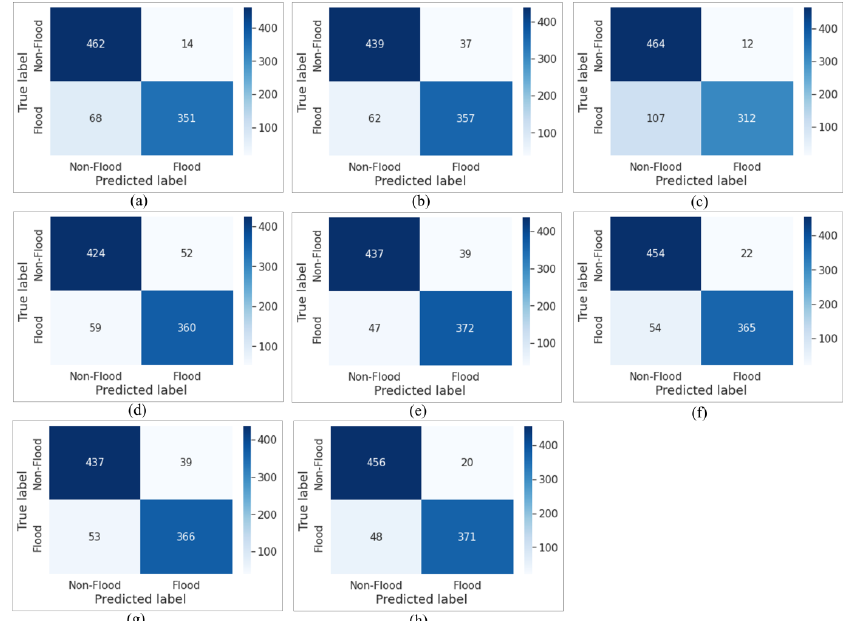
Figure 12. Comparing the confusion matrices of different SFM models in the Gorganrud basin. ( a ) Support Vector Machine (SVM), ( b ) Random Forest (RF), ( c ) Deep Neural Network (DNN), ( d ) De- cision Tree (DT), ( e ) Light Gradient Boosting Machine (LightGBM), ( f ) Categorical Boosting (Cat- Boost), ( g ) Extreme Gradient Boosting (XGBoost), and ( h ) Cascade Forest Model (CFM). The FSM results over the Gorganrud basin were evaluated using the ROC curve for all models (Figure 13). Overall, the CFM AUC = 0.954 and CatBoost 𝐴𝑈𝐶 = 0.959 models were the most efficient ones. The DT model provided the lowest performance among FSM models with AUC = 0.876. The remaining five FSM models (SVM, RF, DNN, XGBoost, and LightGBM) also had a lower AUC compared to CFM.